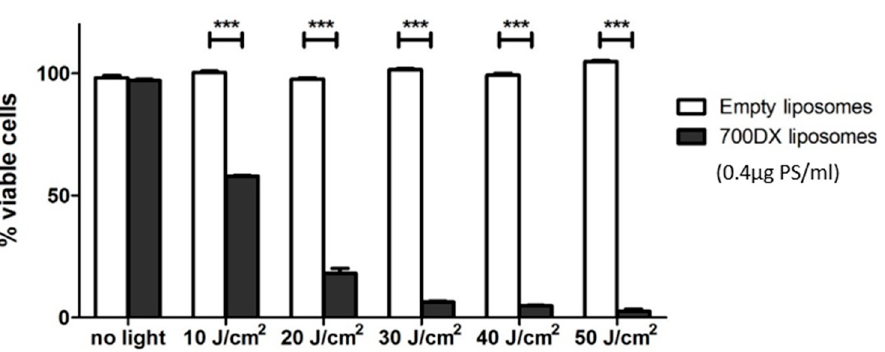
Figure 1. PDT using 700DX-liposomes in RAW 264.7 cells. Cell viability decreased in a light dose dependent manner after incubation with IRDye700DX-liposomes. Cell viability was not affected in cells incubated with control liposomes for any of the tested light doses. Data were normalized to the luminescent values of cells not incubated with liposomes and not exposed to light, and are depicted as mean ± SD ( n = 3). Two-way ANOVA with Bonferroni post-test, *** = p < 0.001.